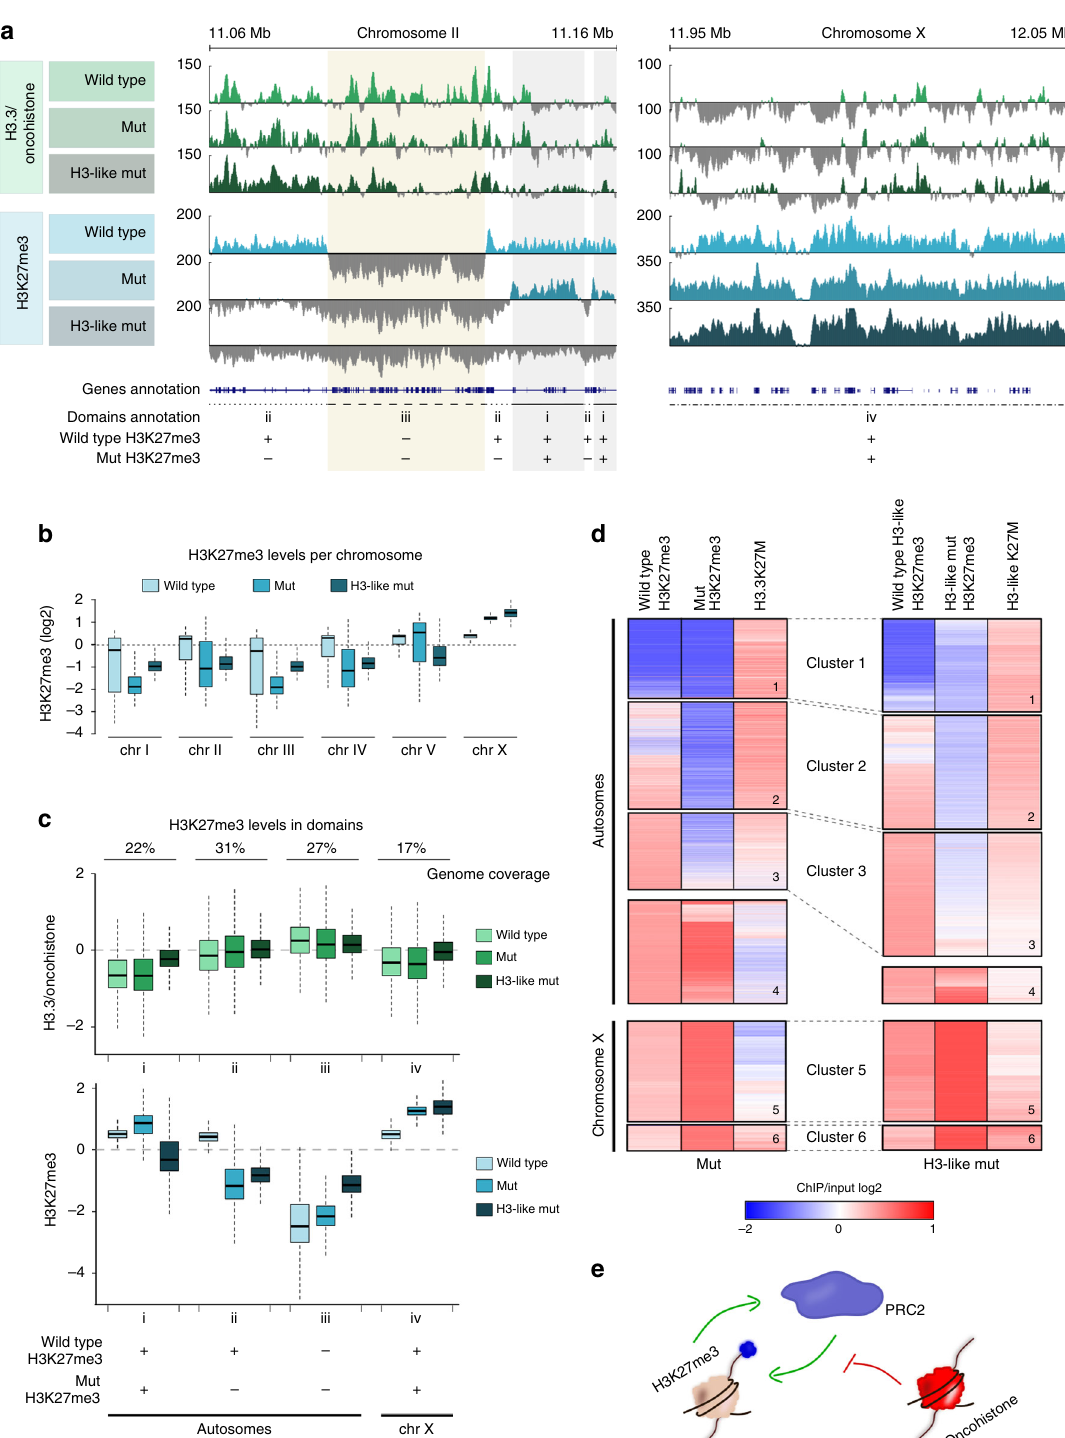
H3.3K27M-induced phenotypes are driven by JNK misregula- tion . H3.3K27M-mediated H3K27me3 redistribution leads to extensive gene misregulation in human cells 9,41 . Many of these